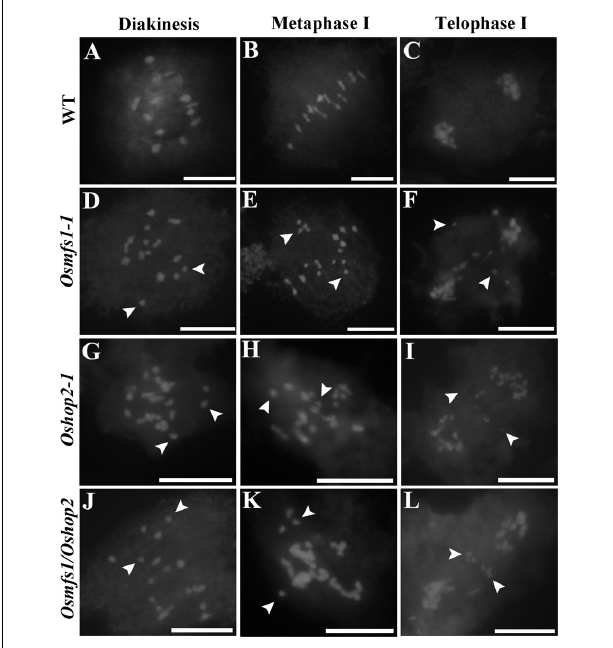
FIGURE 10 | Analysis of meiotic chromosome behavior in Osmfs1-1 , Oshop2-1 , Osmfs1/Oshop2, and WT. (A,D,G,J) pollen mother cell in diakinesis. (B,E,H,K) pollen mother cell in metaphase I. (C,F,I,L) pollen mother cell in telophase I. The mutant Oshop2-1 and Osmfs1/Oshop2 shared the same chromosomal defects with Osmfs1-1 . The white arrows point to free univalents. Bars = 50 µ